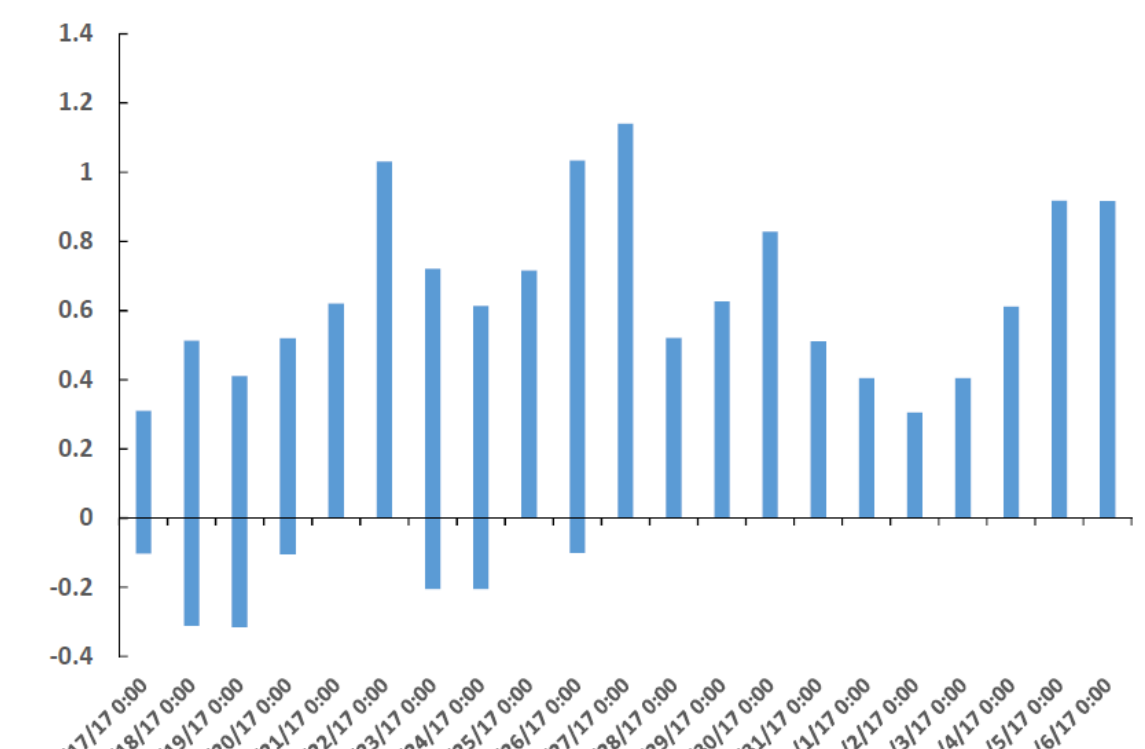
Figure 2. Maximum and minimum temperature differences (from six measurements per day) between a shallow habitat (1–2 m) containing only C. xamachana vs. a deeper habitat (3–4 m) containing both C. frondosa and C. xamachana . Temperatures ranged from 29 °C to 34 °C, and negative values indicate occasions when the shallower habitat was colder than the deeper habitat. Days go from midnight (0:00) to midnight.